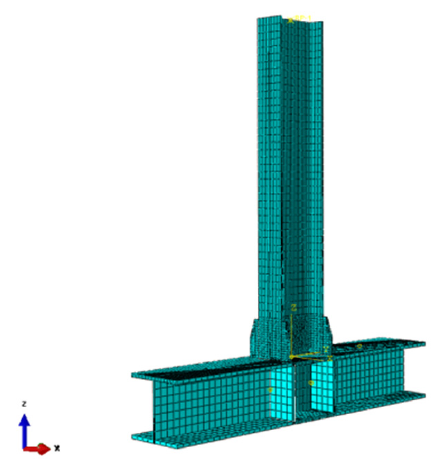
Figure 11. Material constitutive model.